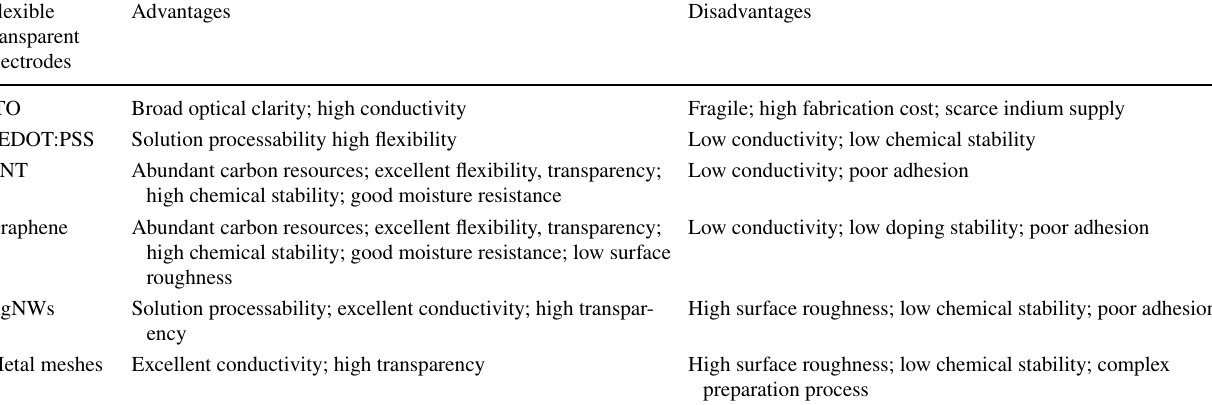
Table 2 Comparision of different flexible transparent electrodes Flexible